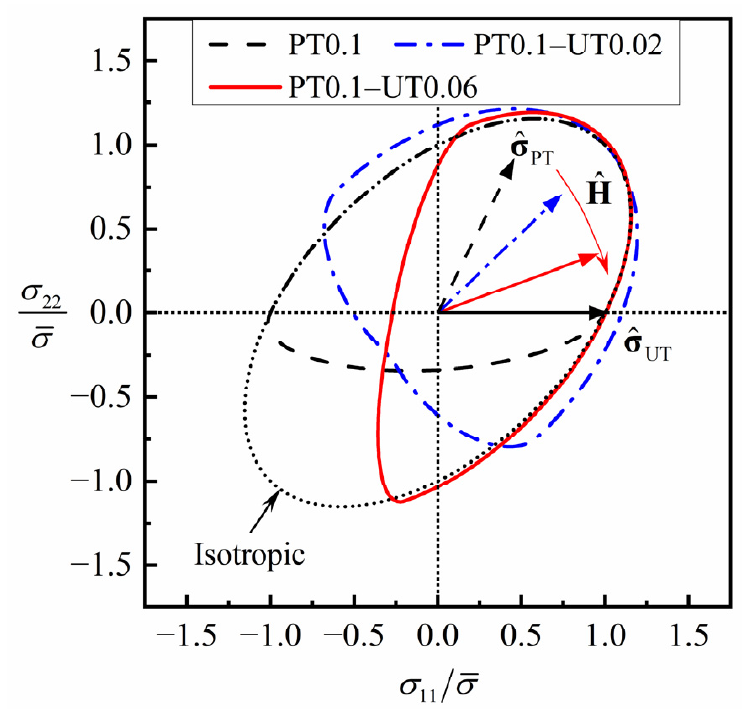
model in plane strain tension–uniaxial tension.